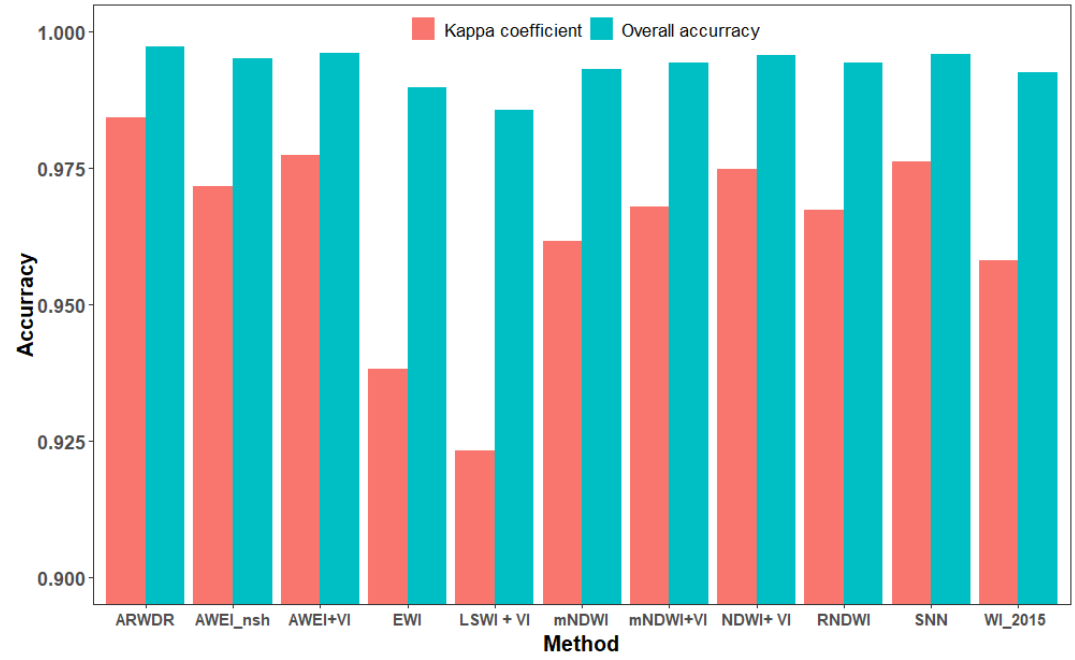
Figure 5. Comparison of different water detection rules.